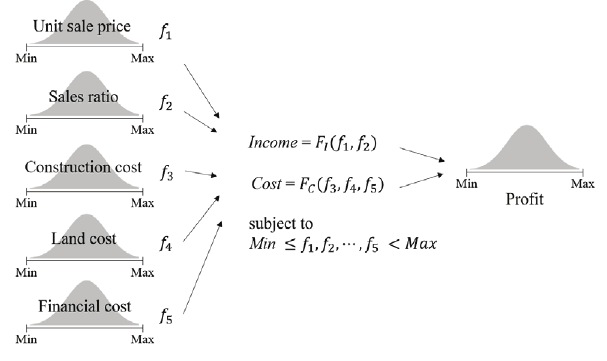
Figure 3. Simulation model concept